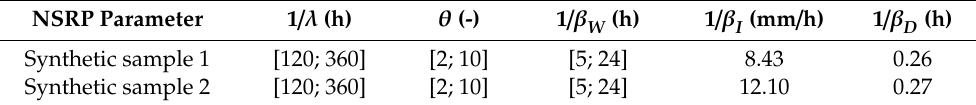
Table 5. NSRP parameters for two synthetic samples derived from EV1 parameters in Table 3.